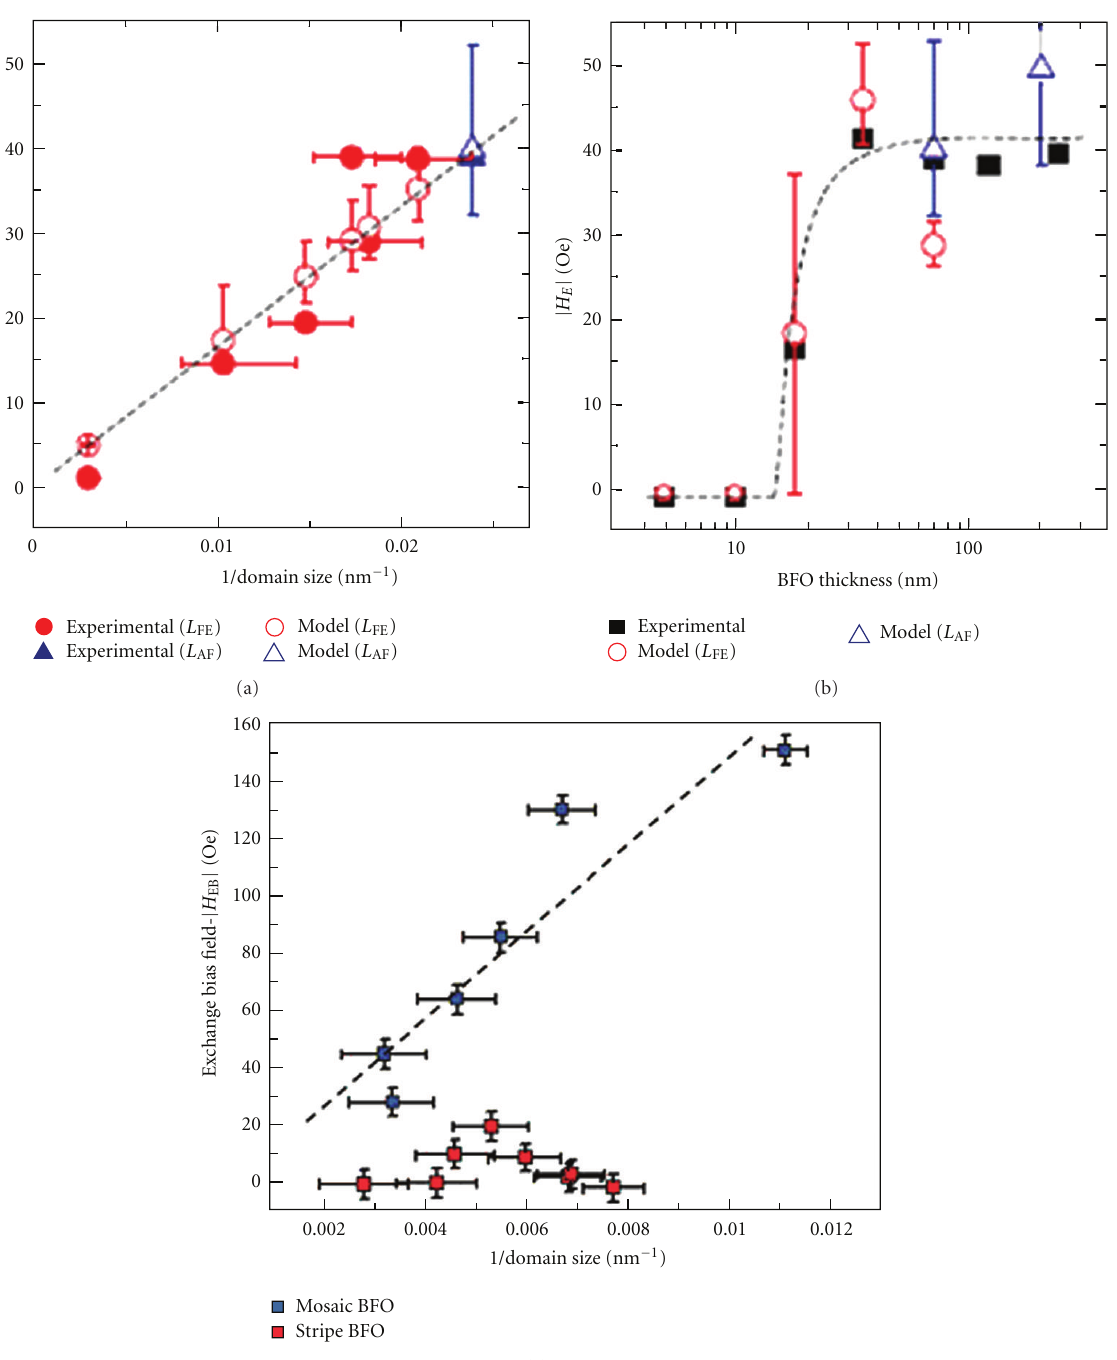
Figure 4: Dependence of exchange bias (a) on domain size in 65nm BFO thin films, (b) on thickness of CoFeB/BFO stacks deposited on STO (001), and (c) on domain size of CoFe/BFO heterostructure grown on mosaic-like and stripe-like BFO films. Figures were reproduced with permission from Martin et al. [48] and B´ea et al.